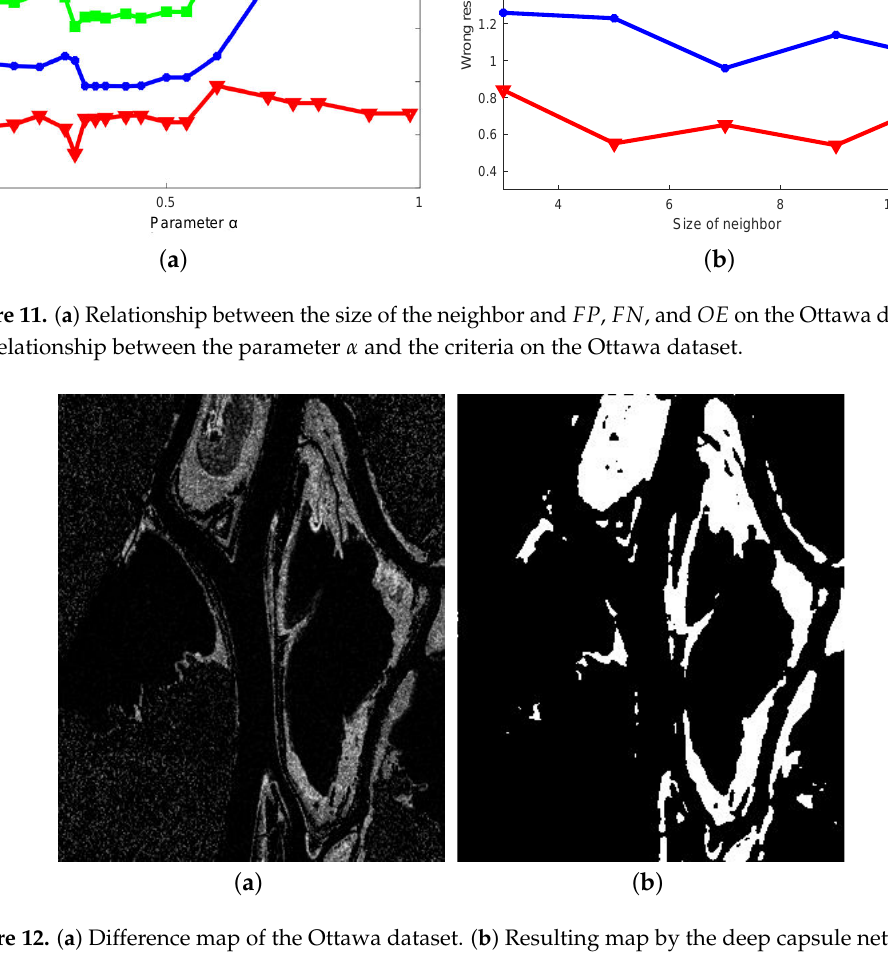
Figure 12. ( a ) Difference map of the Ottawa dataset. ( b ) Resulting map by the deep capsule